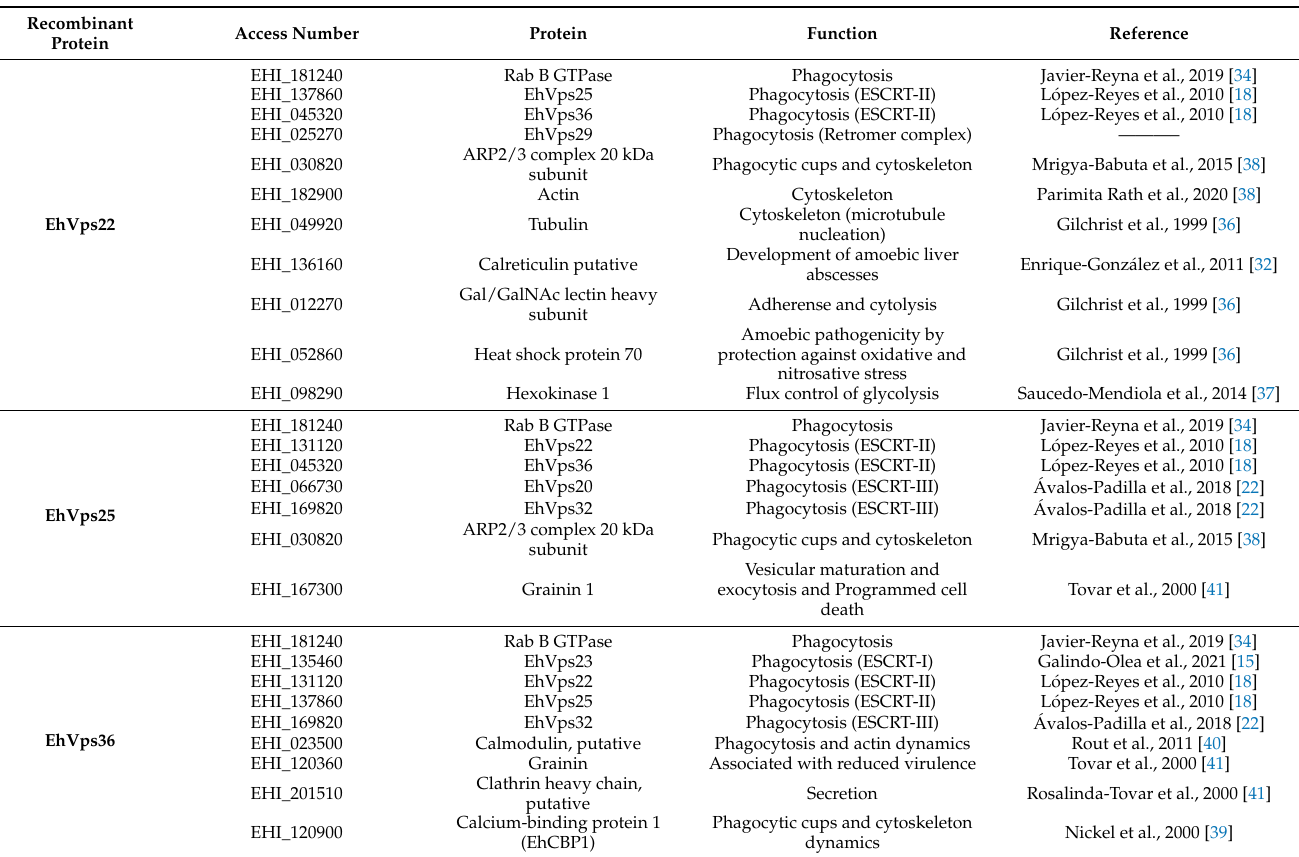
Table 1. rEhVps25, and rEhVps36 with proteins involved in phagocytosis and cytoskeleton. Data were obtained by mass spectrometry analysis with a reliability percentage >95%. The database AmoebaDB (https://amoebadb.org/amoeba/app, accessed on November 2022) was used to provide the accession number of each